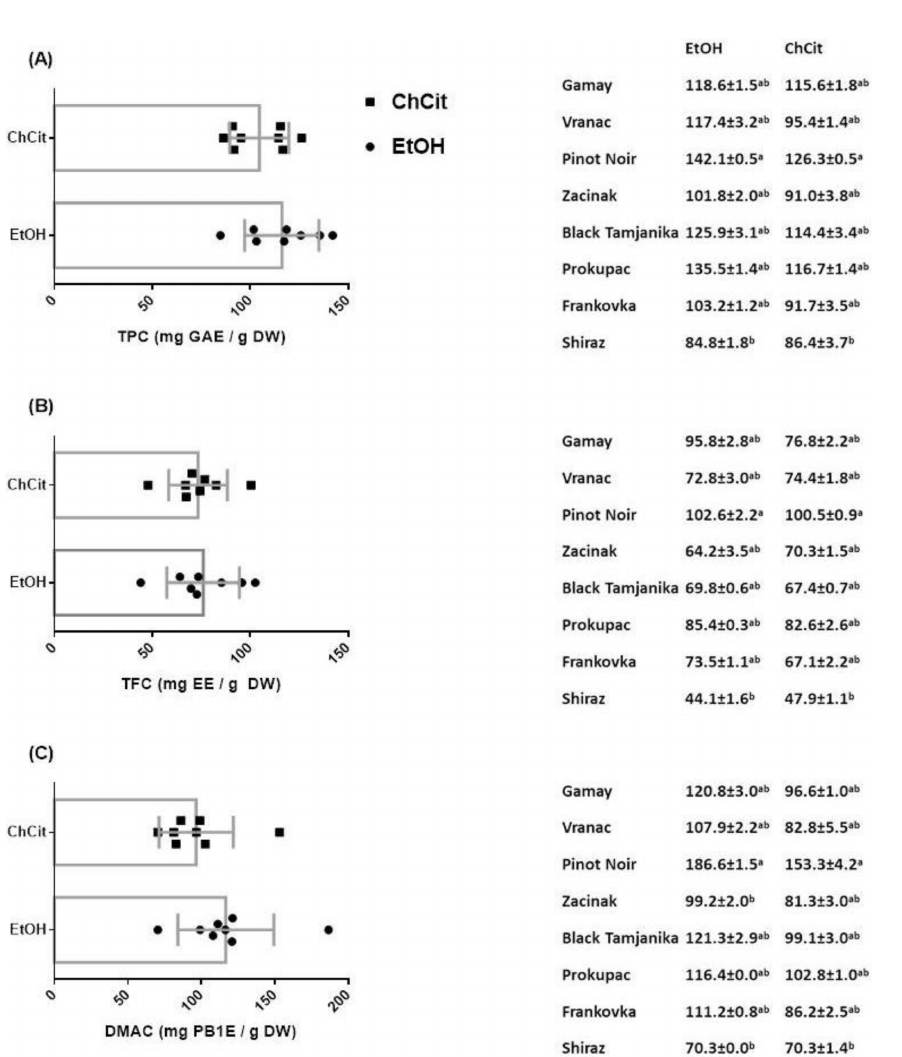
Figure 1. Total phenolic content ( A ); total flavonoid content ( B ) and total flavan-3-ol content ( C ) of GSEs. Data are expressed as mean ( n = 8) ± SD for solvent impact and as mean ( n = 3) ± SD for variety impact. Lower-case letters indicate significant difference in each group ( p < 0.05)